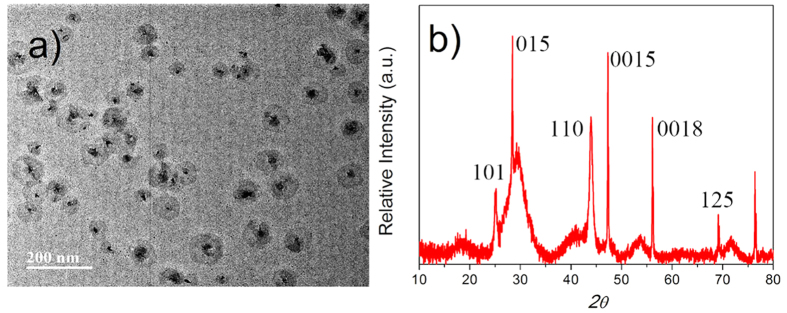
Bi2Se3 nanoplatelets.SEM image (a) and the XRD diffraction pattern (b) of Bi2Se3 NPs.